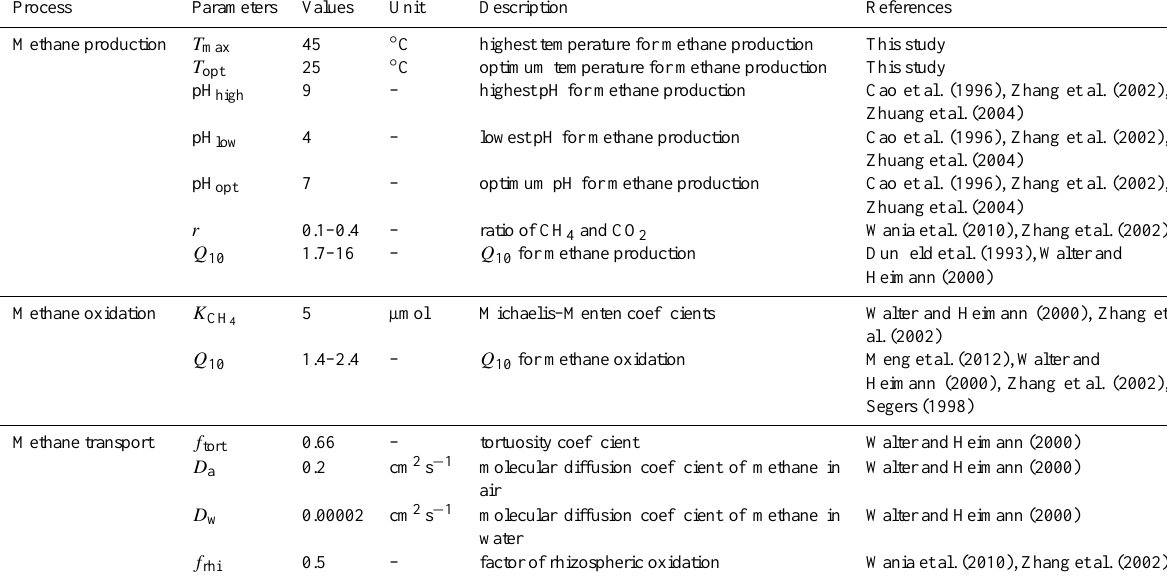
Table 1. List of major parameters in CH 4 production, oxidation and transportation.